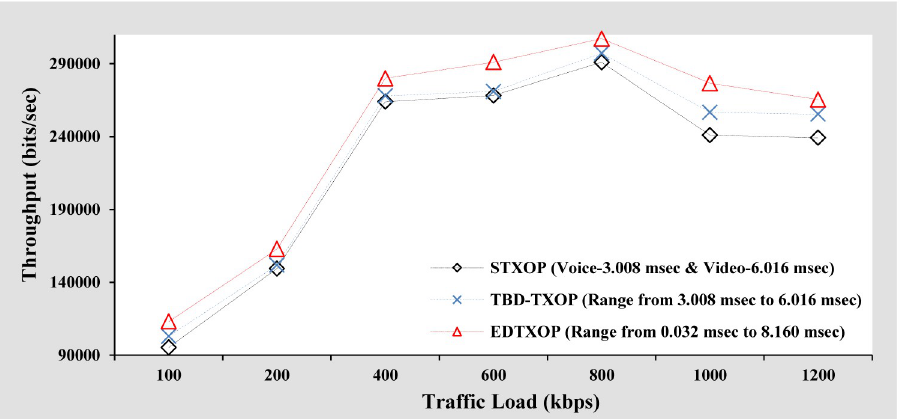
Fig 8. Throughput analysis based on increasing packets arrival